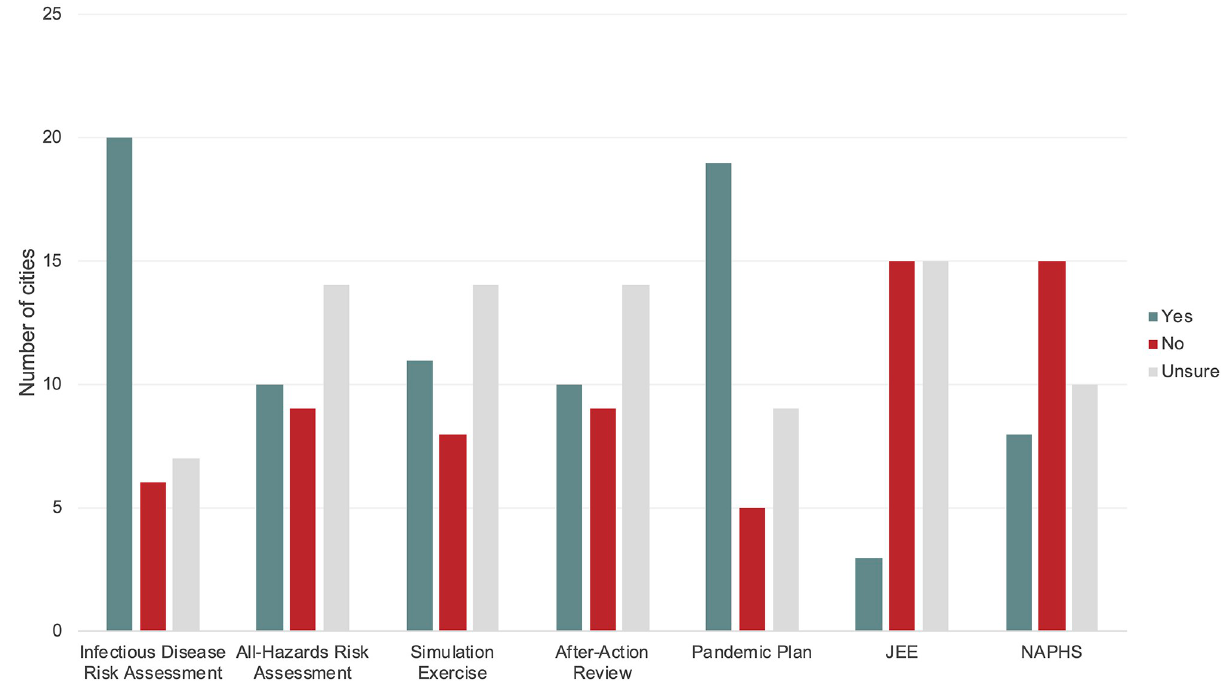
Fig 1. The number of cities that had completed or engaged in pandemic preparedness efforts prior to the COVID-19